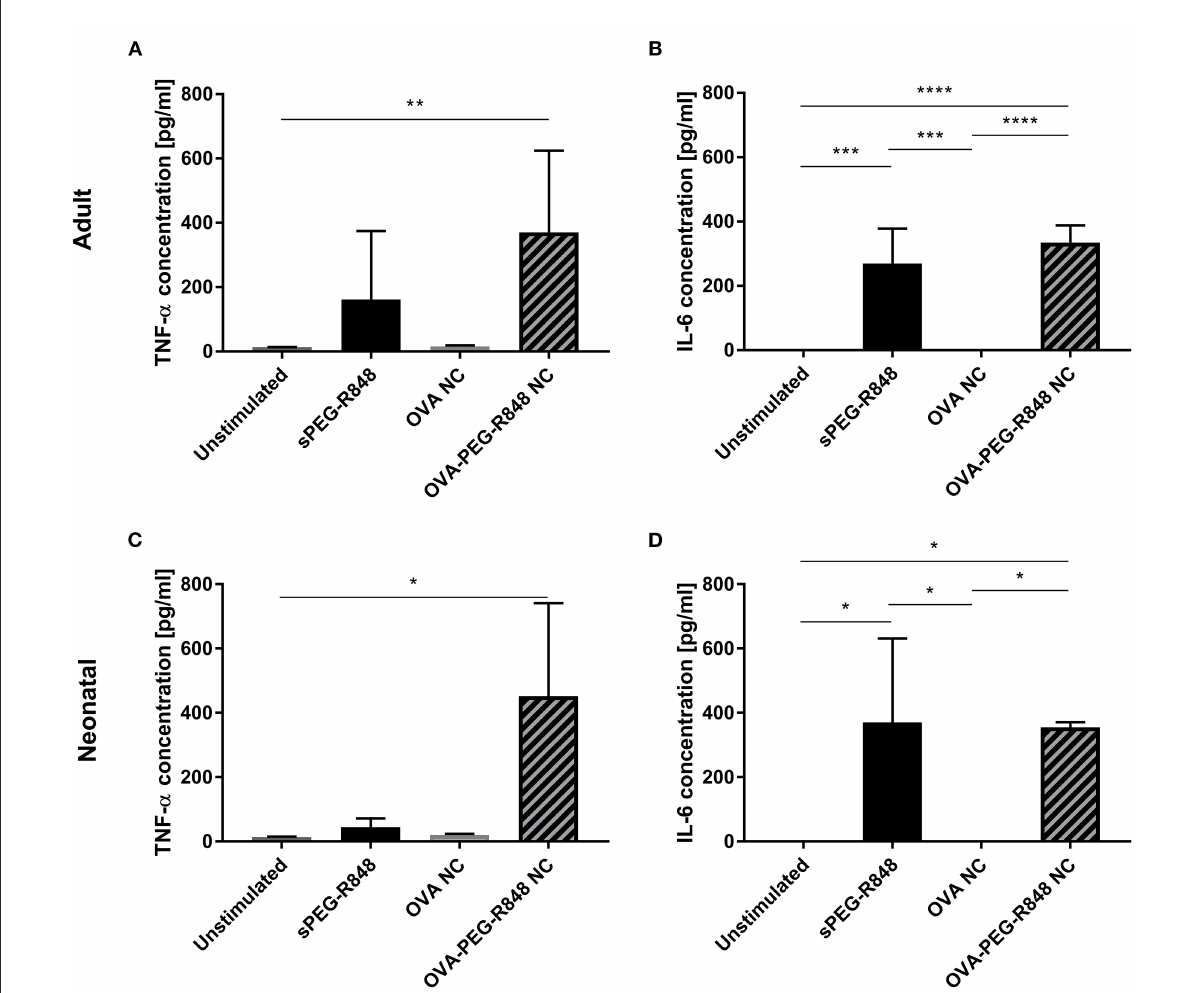
FIGURE7 PEG-R848 encapsulation increases cytokine secretion. Analysis of TNF- α (A,C) and IL-6 (B,D) secretion by adult (A,B) and neonatal (C,D) DCs after incubation with soluble PEG-R848, empty OVA NCs or OVA-PEG-R848 NCs. Data represent the means ± SD ( n = 3). Significantly different: * P < 0.05; ** P < 0.01; *** P < 0.005; **** P < 0.0001 (one-way